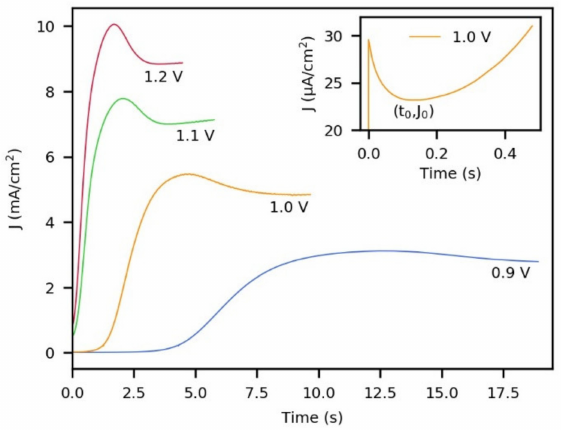
Figure 1. Current–time transients for the electropolymerization of pyrrole on FTO substrates at different anodic potentials. Synthesis solution (0.25 M pyrrole and 0.5 M LiClO 4 in acetonitrile +2% w / w H 2 O). The inset shows a magnification of the curve at 1.0 V at a very early time in the